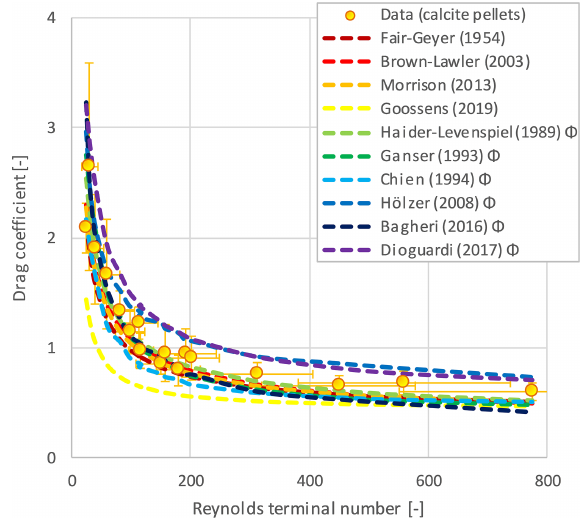
Figure 6. Drag coefficient prediction (average values on a linear–linear (lin–lin) scale) accuracy for calcite pellets (0.36 <d p < 2.8mm), including (measured) error bars based on in- dividual terminal settling experiments ( N = 1163). (cid:56) indicates that the measured sphericity is included in the model.